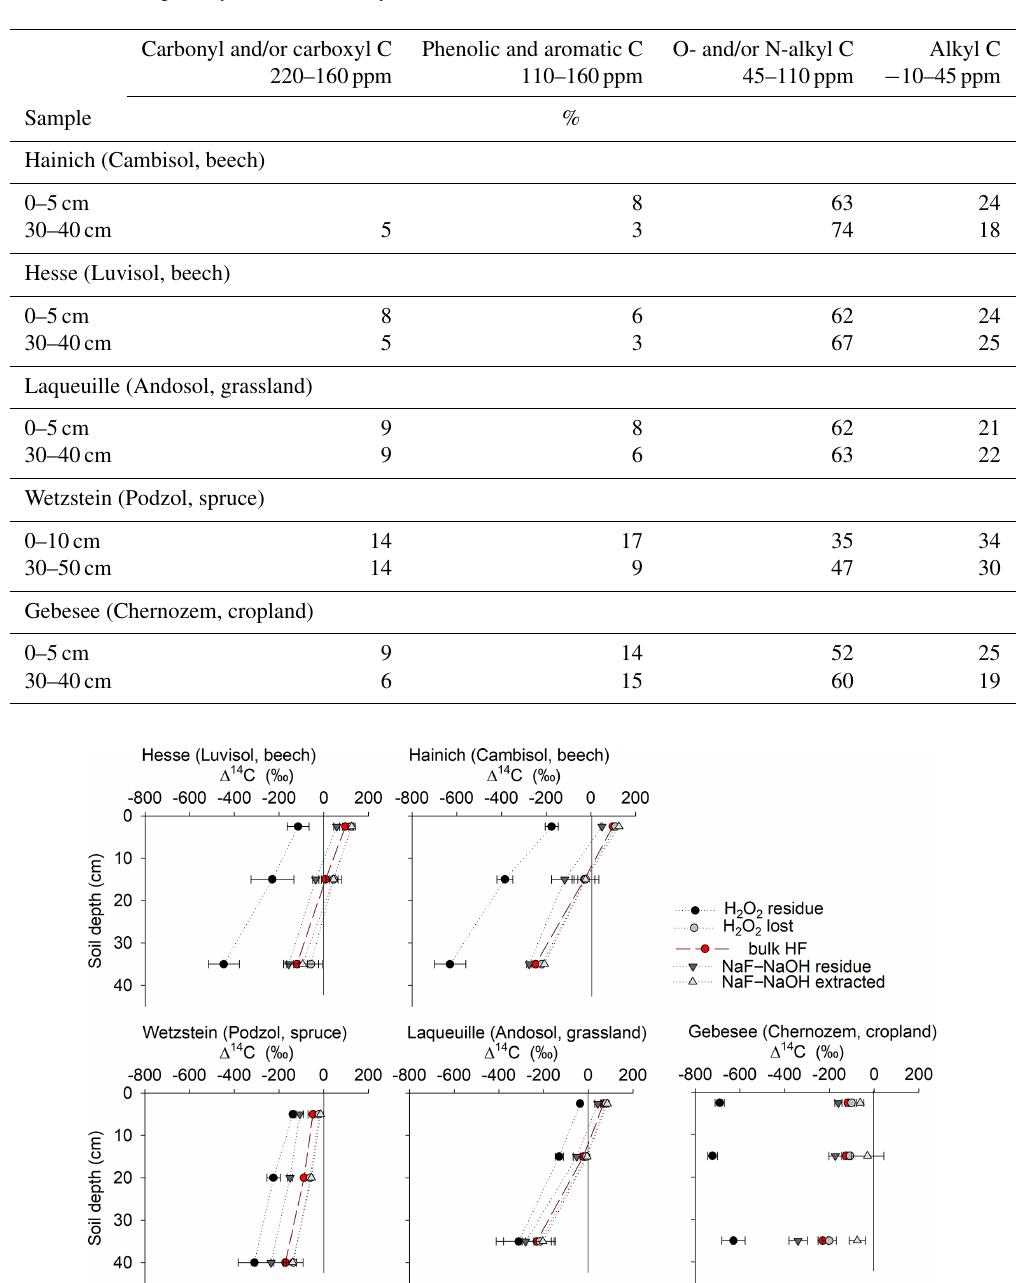
Figure 5. Depth profiles of radiocarbon ( (cid:49) 14 C) in bulk mineral-associated OC (bulk MOC), as well as in OC removed from mineral surfaces using either NaF–NaOH or H 2 O 2 , and in the respective OC residues remaining on mineral surfaces.